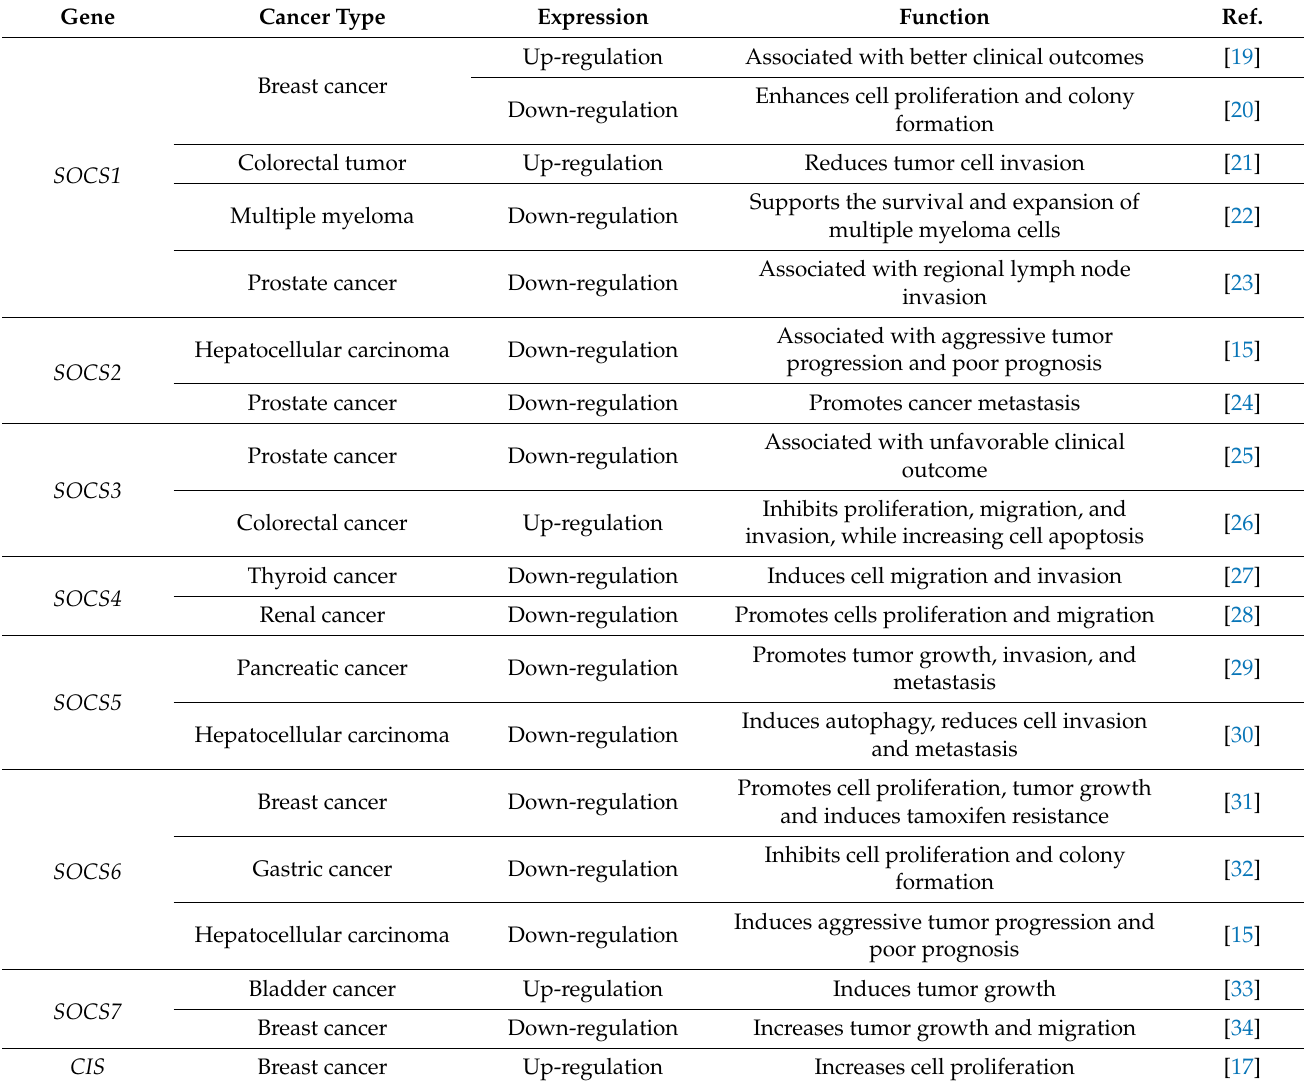
Table 1. Contrasting roles of suppressors of cytokine signaling (SOCS) in the development of cancer.